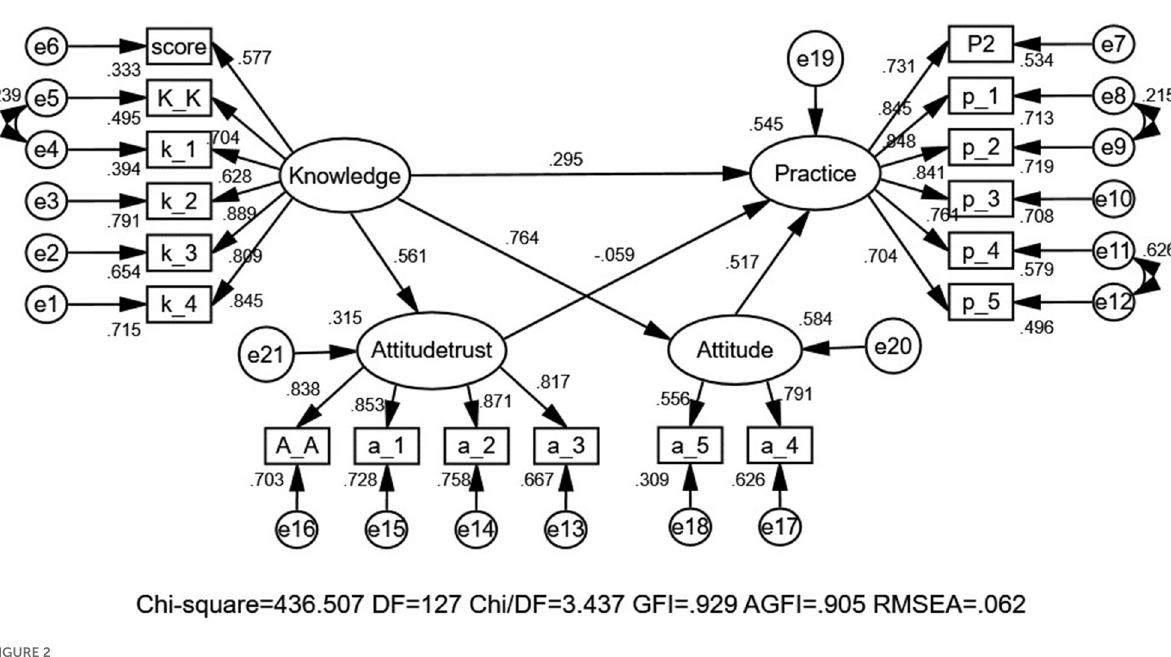
the relationship between indicators. In this study, SEM is helpful to analyze the direct effects of the nutrition label KAP and to reveal these relationships. However, there are still a few limitations in